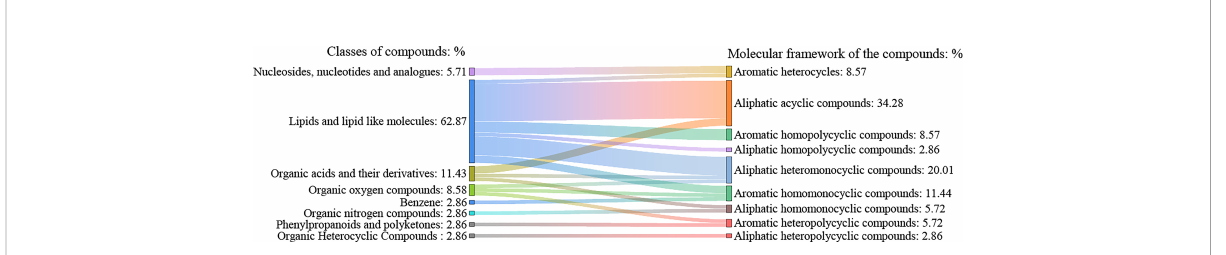
FIGURE 2 Molecular framework statistical map of differential compounds in maize root exudates after AMF colonization. The left side of the fi gure shows the classi fi cation of maize root exudates with signi fi cant differences after AMF colonization, and the right side shows the carbon skeleton corresponding to these root